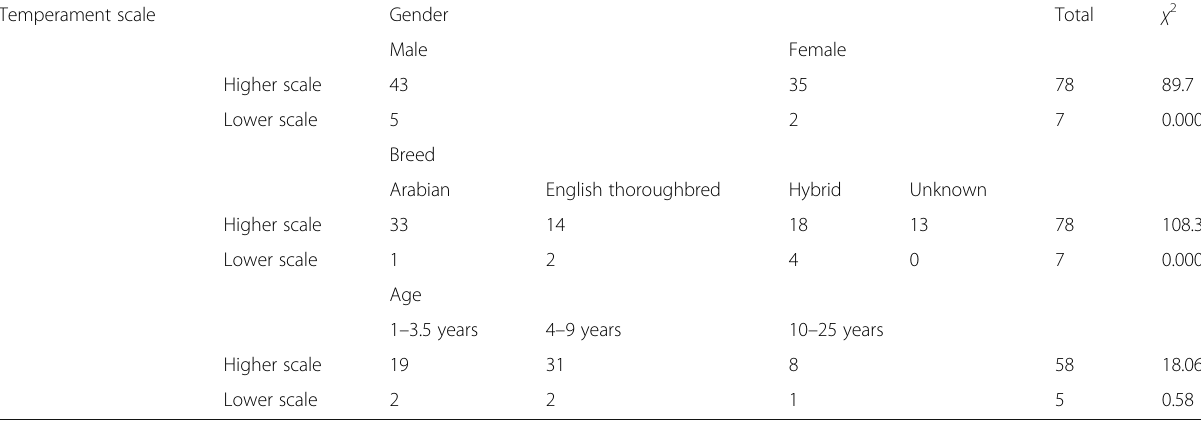
Table 2 Association between temperament scale and horse ’ s gender, breed, and age Temperament scale